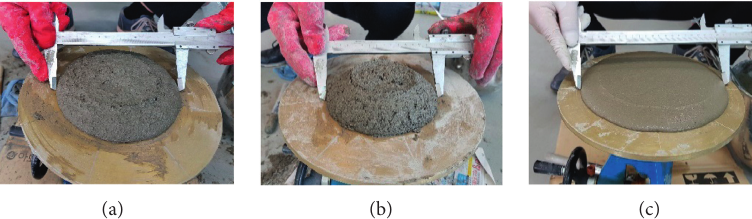
Figure 6: Flow test of mortar samples: (a) SiO 2 -coated carbon fiber mortar, (b) uncoated carbon fiber mortar, and (c) plain mortar.